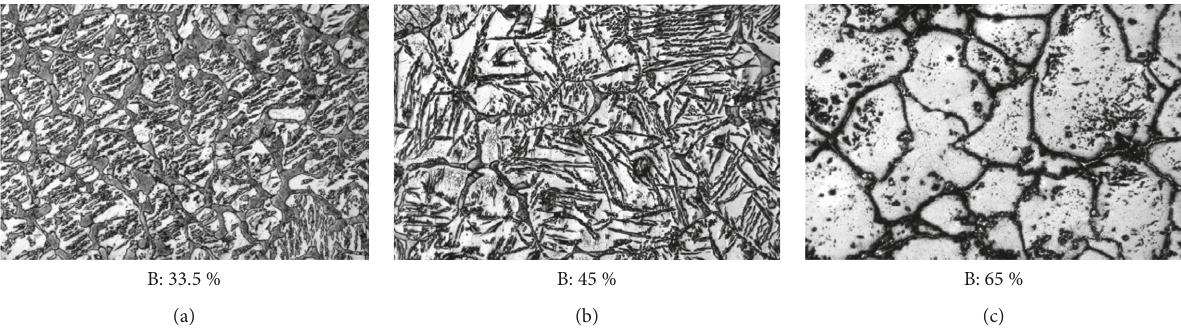
B: 33.5 % Figure 2: Annotated images taken at 100X for the as-cast samples at (a) C1, (b) C2, and (c) C3 showing the distribution of the white phase in volume %.